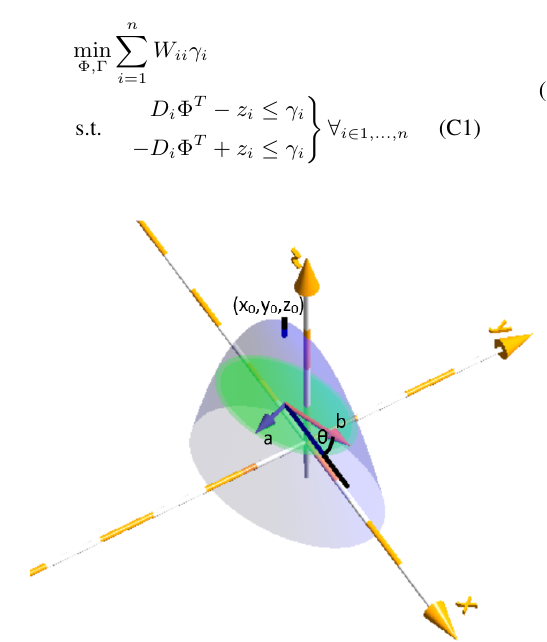
Figure 1. Z-axis aligned elliptic paraboloid centered at ( x 0 , y 0 , z 0 ) , rotated by θ degrees around the Z axis, with semiaxis lengths a, b